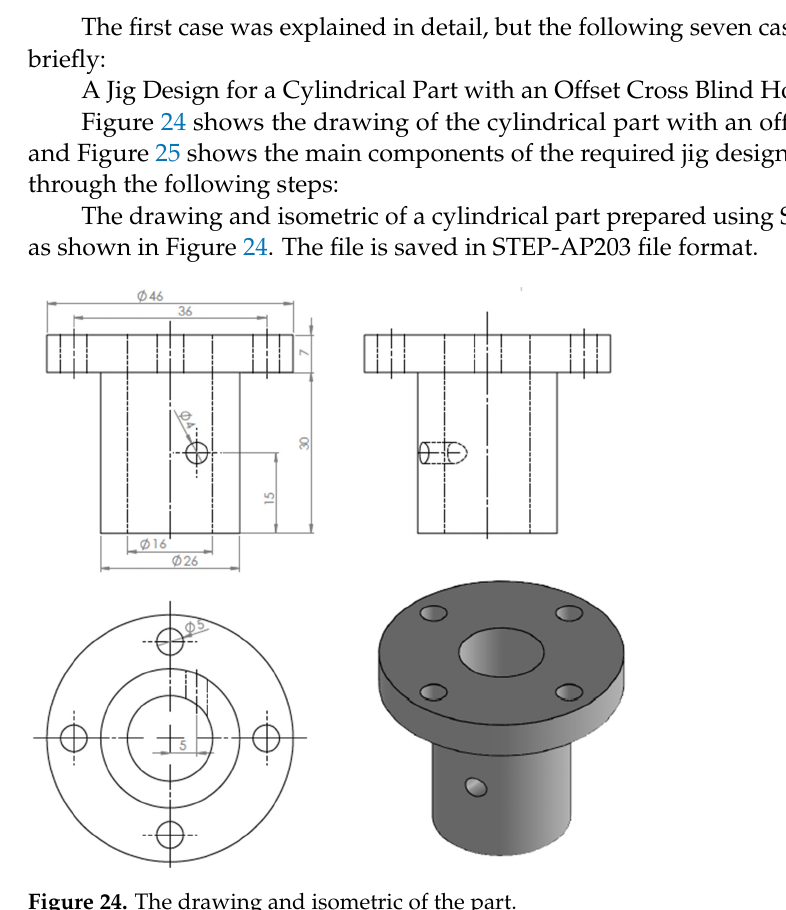
Figure 24. The drawing and isometric of the